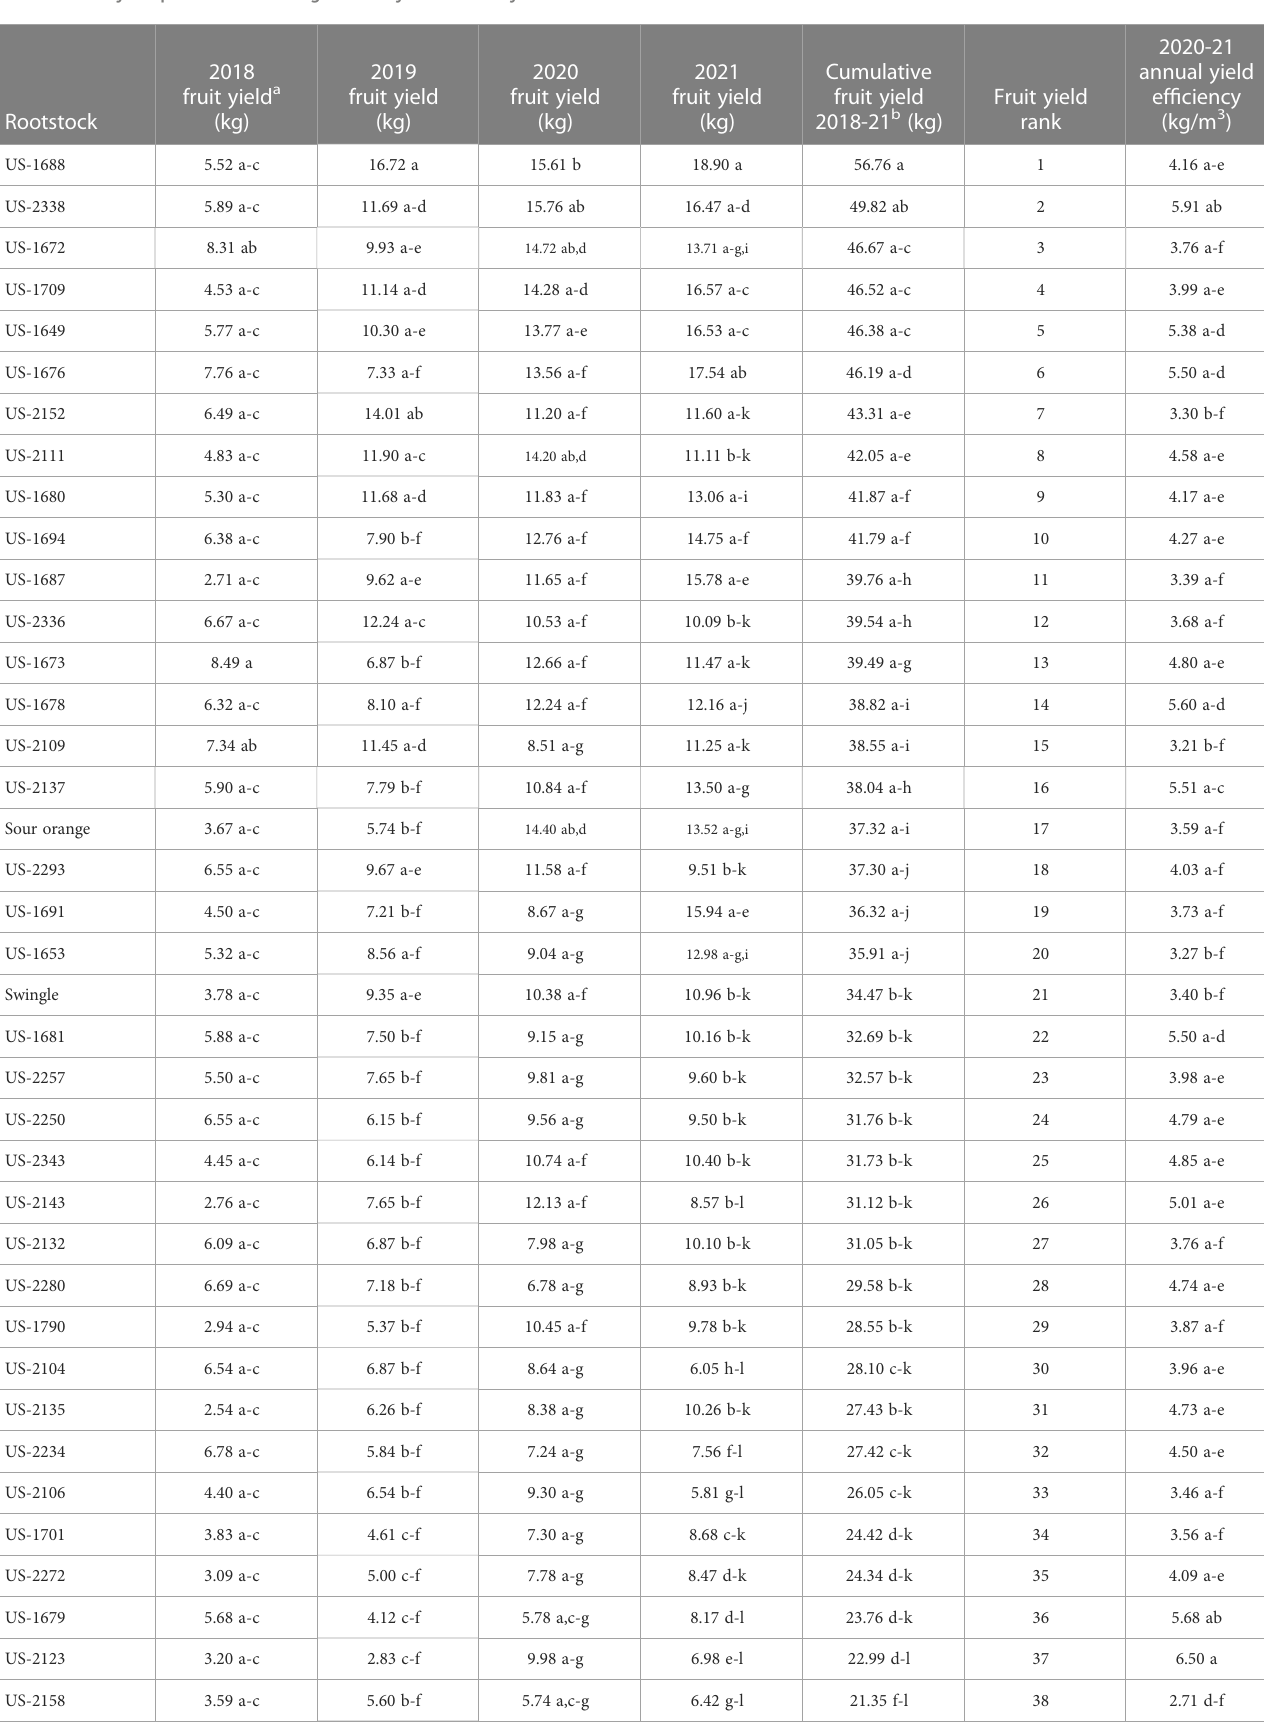
TABLE 3 Fruit yield per tree and average annual yield ef fi ciency.